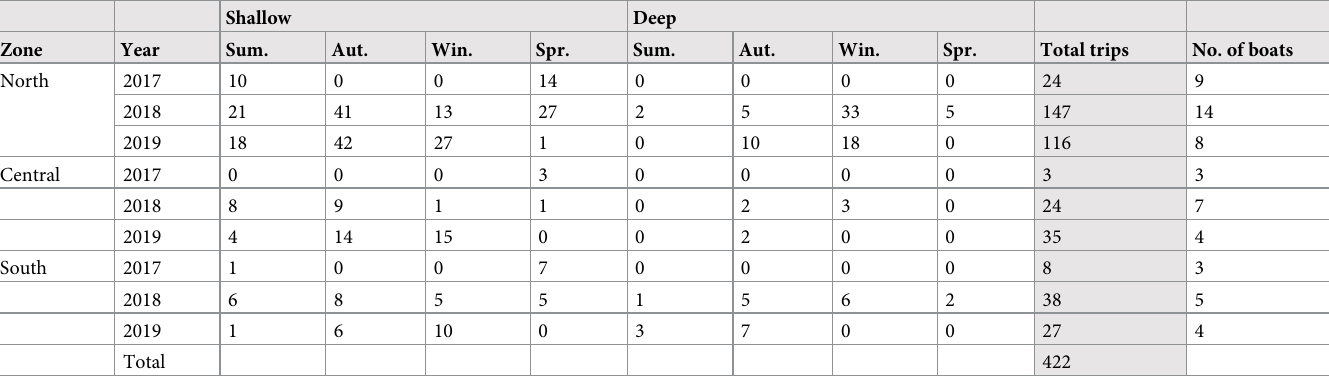
Total 422 Note: Sum = Summer, Aut = Autumn, Win = Winter, Spr = Spring, No. = number.